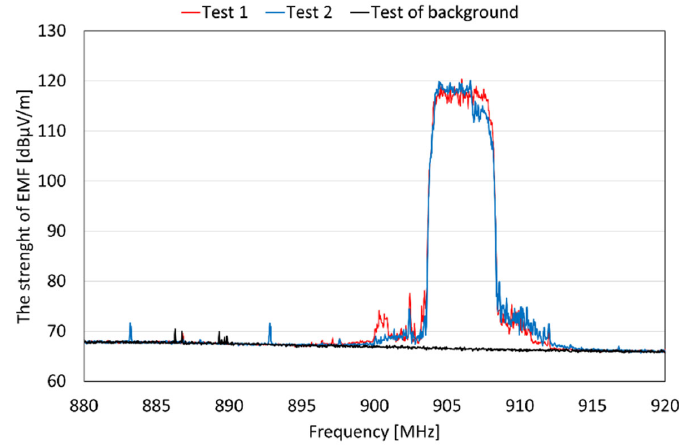
Figure 6. Measurement results of electromagnetic field strength generated from a Samsung phone at